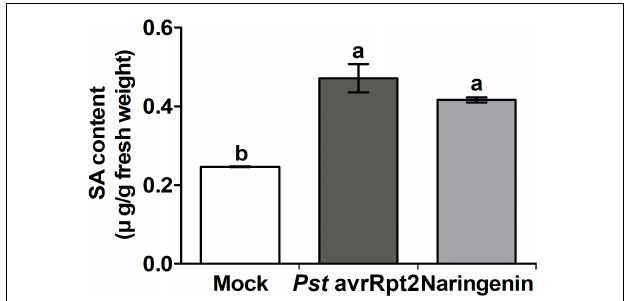
FIGURE 4 | Naringenin induces the accumulation of SA. Accumulation of SA by naringenin. SA was extracted from Col-0 plants treated with Pst DC3000 avrRpt2 or 100 µ M naringenin. The leaves were sampled 24 h after treatment. Accumulation of SA was measured by HPLC-MS/MS. Data represent the mean SD of at least three biological replicate leaf samples from different plants. Each biological replicate consists of three leaves from three plants.